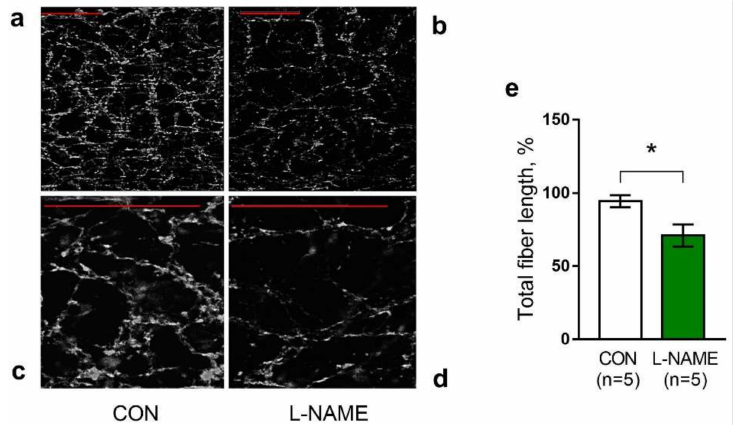
Figure 3. The density of sympathetic innervation of the saphenous artery is reduced in two-week-old L-NAME offspring. ( a – d ) Representative images of the glyoxylic-acid-stained plexus of adrenergic nerve fibers in the saphenous artery walls of control ( a , c ) and L-NAME ( b , d ) offspring (scale bar: 50 µ m). ( e ) The total length of adrenergic fibers in the saphenous artery of the offspring from the control and L-NAME groups. n , number of animals. Data are presented as the mean ± S.E.M., * p < 0.05 (unpaired Student’s t -test).